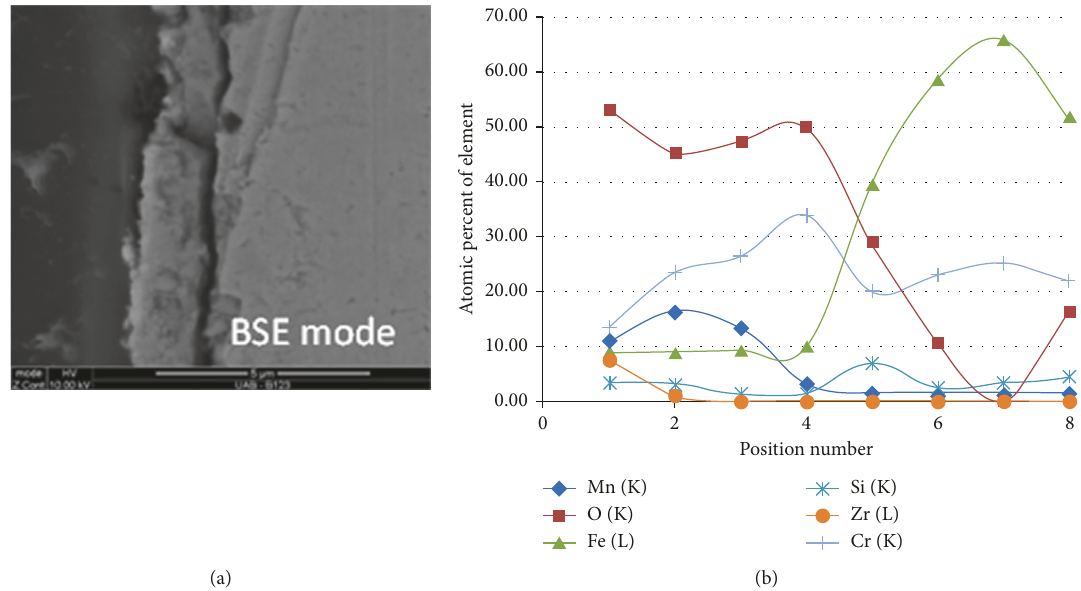
Figure 12: YSZ-B123: EDX analyses were run fairly evenly spaced in a line from 1 through 8 for the thermally soaked